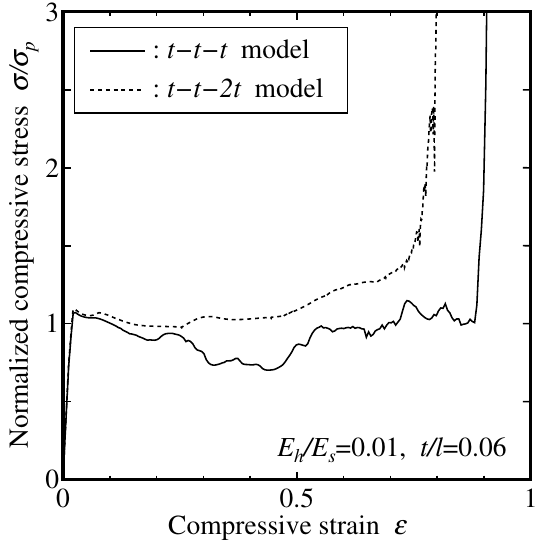
Figure 15. Stress-strain responses of Type II for the t - t - t and t - t - 2 t